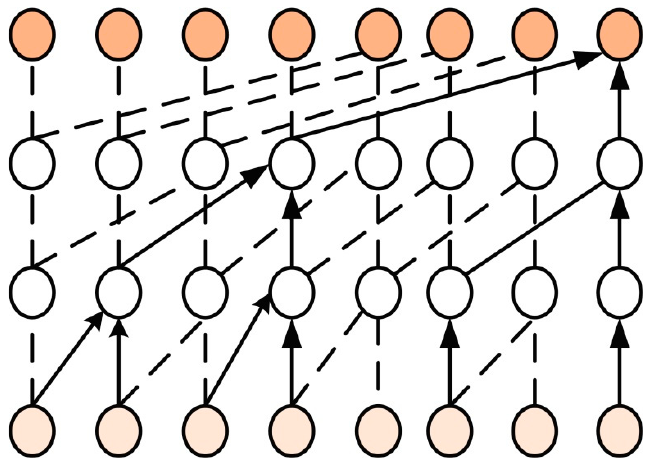
Figure 2. Dilated causal convolution architecture.